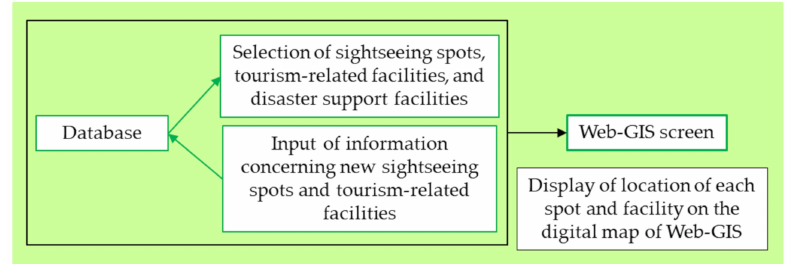
Figure 3. Sequence of steps for